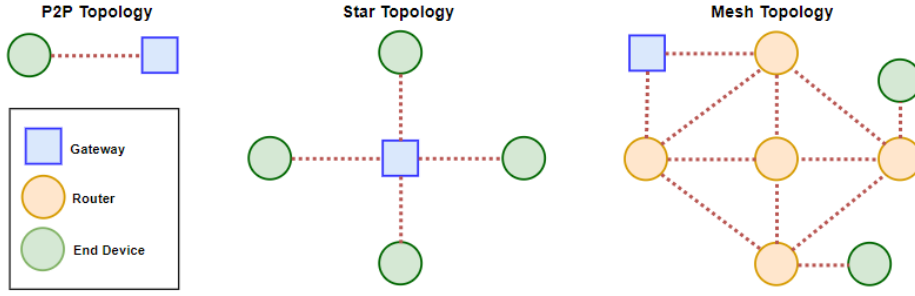
Figure 2. Network topology (adapted from